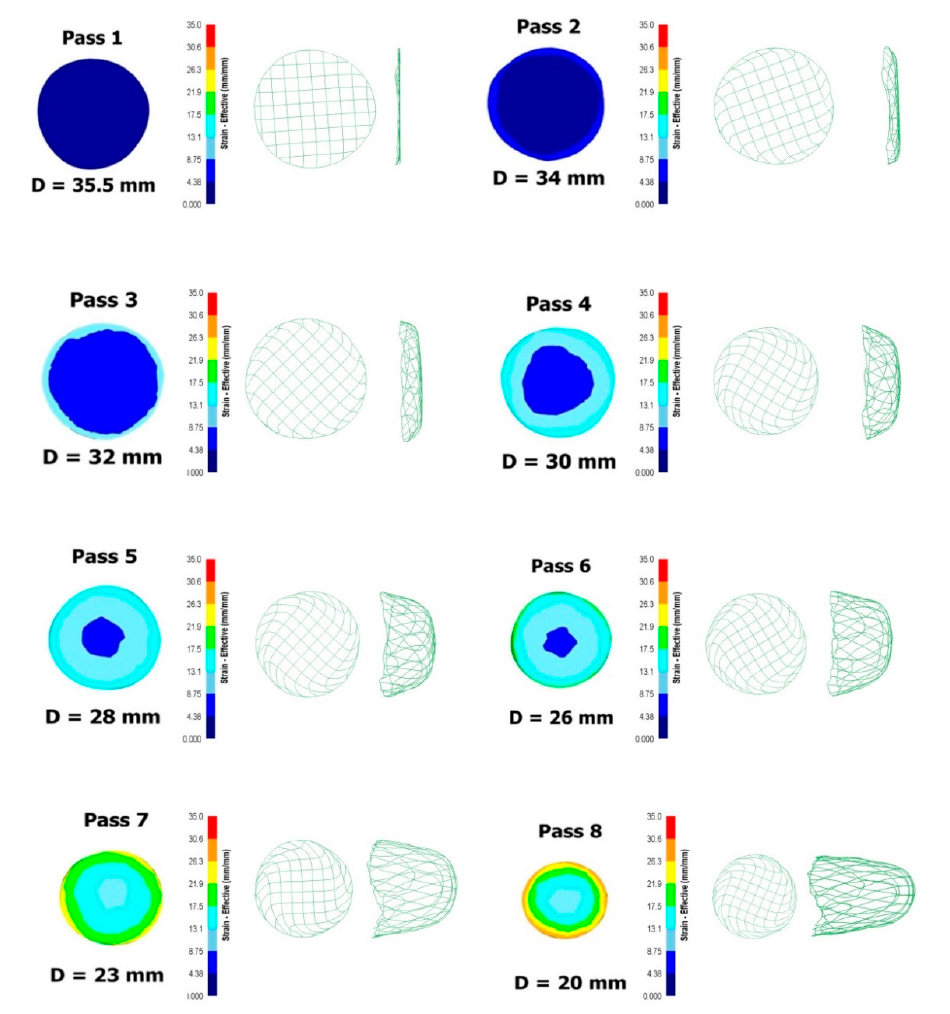
Figure 5. Equivalent strain and fixed grid in the cross section of a zirconium bar after eight passes of radial-shear rolling.